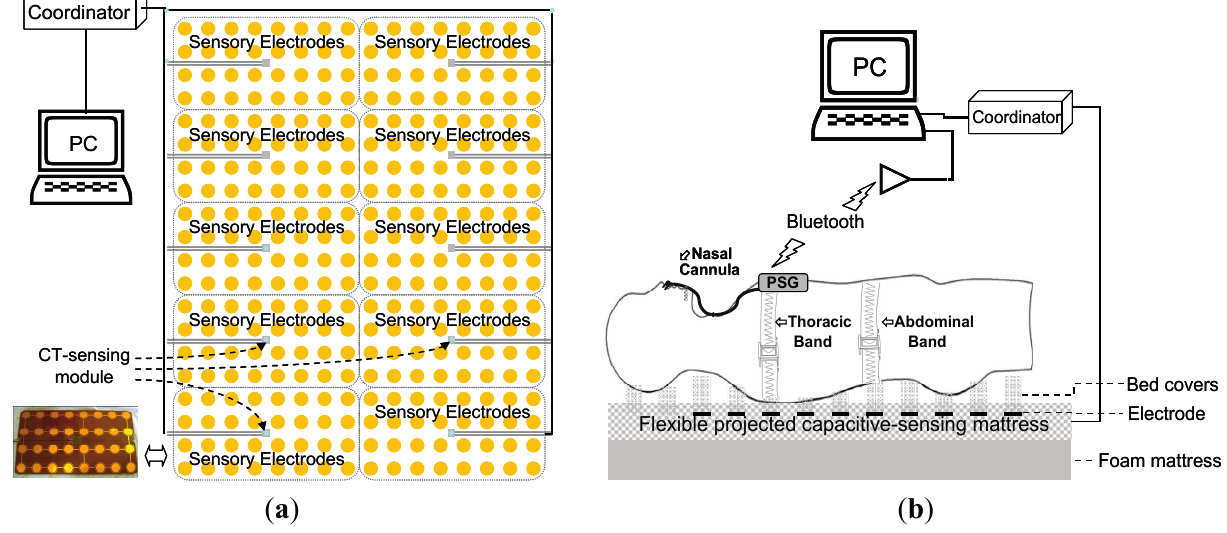
Figure 3. ( a ) The FPCSM system; ( b ) Experimental platform with independent PSG and FPCSM